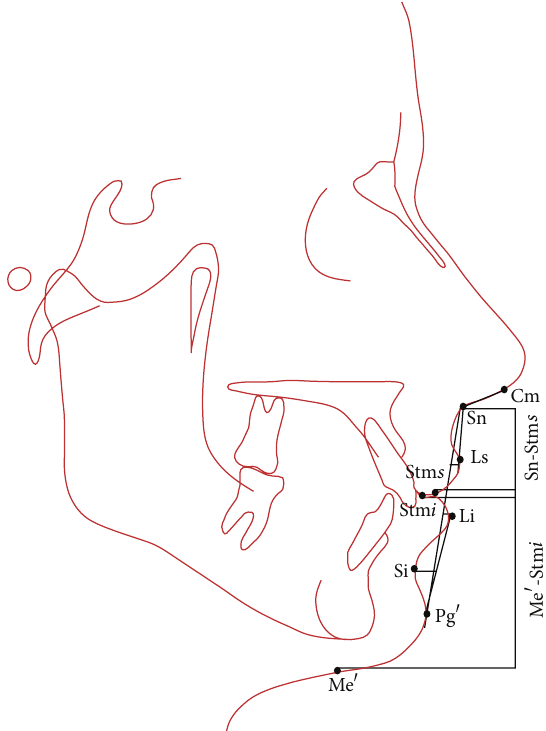
Figure 2: Legan-Burstone soft tissue analysis: lip position. Nasolabial angle (Cm-Sn-Ls); upper lip protrusion (Ls to Sn-Pg 󸀠 ); lower lip protrusion (Li to Sn-Pg 󸀠 ); mentolabial sulcus (Si to Li- Pg 󸀠 ); vertical lip-chin ratio (Sn-Stms/Stmi-Me 󸀠 ); maxillary incisor exposure (Stms-UI); interlabial gap